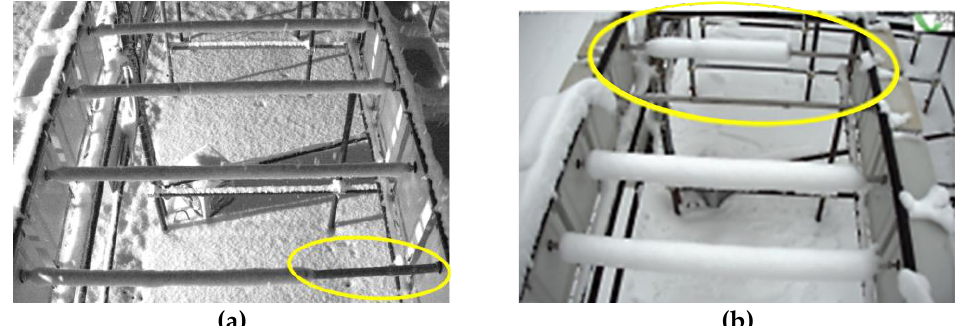
Figure 8. ( a ) Snow-sleeve in formation on the testing samples. A piece of conductor that delay the snow accretion is highlighted in yellow during a snowfall; ( b ) snow-sleeve after a snowfall event. The early shedding of the snow from the conductors is highlighted in a yellow circle. The estimation method for MLI was assessed by comparing the calculated load profile ERL to the data from the load cell for the reference sample during a snow event (Figure 9). The ERL well represents the trend for both the loading and the detachment of the snow sleeve. In the second part of the event (from 1000 min until the end), the density of the snow increased, causing the difference between the real and the calculated snow-weight. As the snow density is the same for all the exposed samples, the calculated ERL is considered to give a reasonable qualitative figure of the accreted sleeves on the samples. In Tables 5 and 6, we collect the RCov and the MLI of the tested samples, compared to the reference